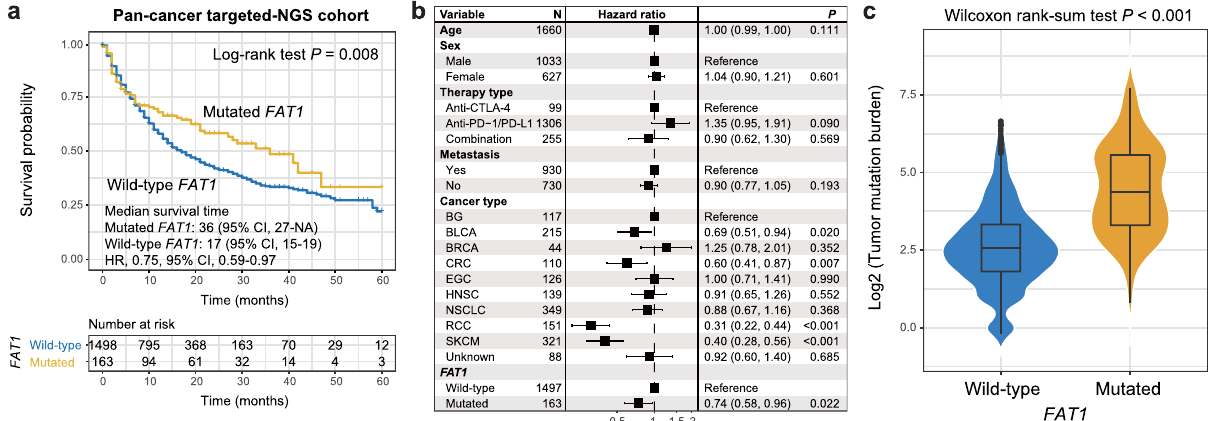
Fig. 6 Validation of ICI predictive ability of FAT1 mutations with a pan-cancer cohort. a Kaplan – Meier survival curves strati fi ed by FAT1 mutational status. b Multivariate Cox regression model between FAT1 mutations and ICI outcome with clinical confounding factors taken into account. Black box: hazard ratio; black scale bar, 95% con fi dence interval of hazard ratio. c Association of FAT1 mutations with TMB in the pan- cancer